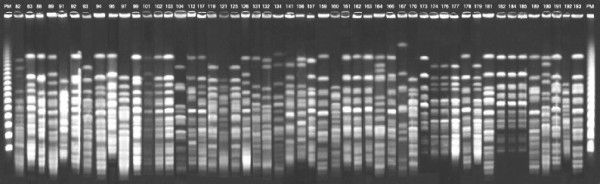
Pulsed-field gel electrophoresis results showing different clones of carbapenem-resistant P. aeruginosa compared with endemic clone represented by numbers 161, 162 and 163.